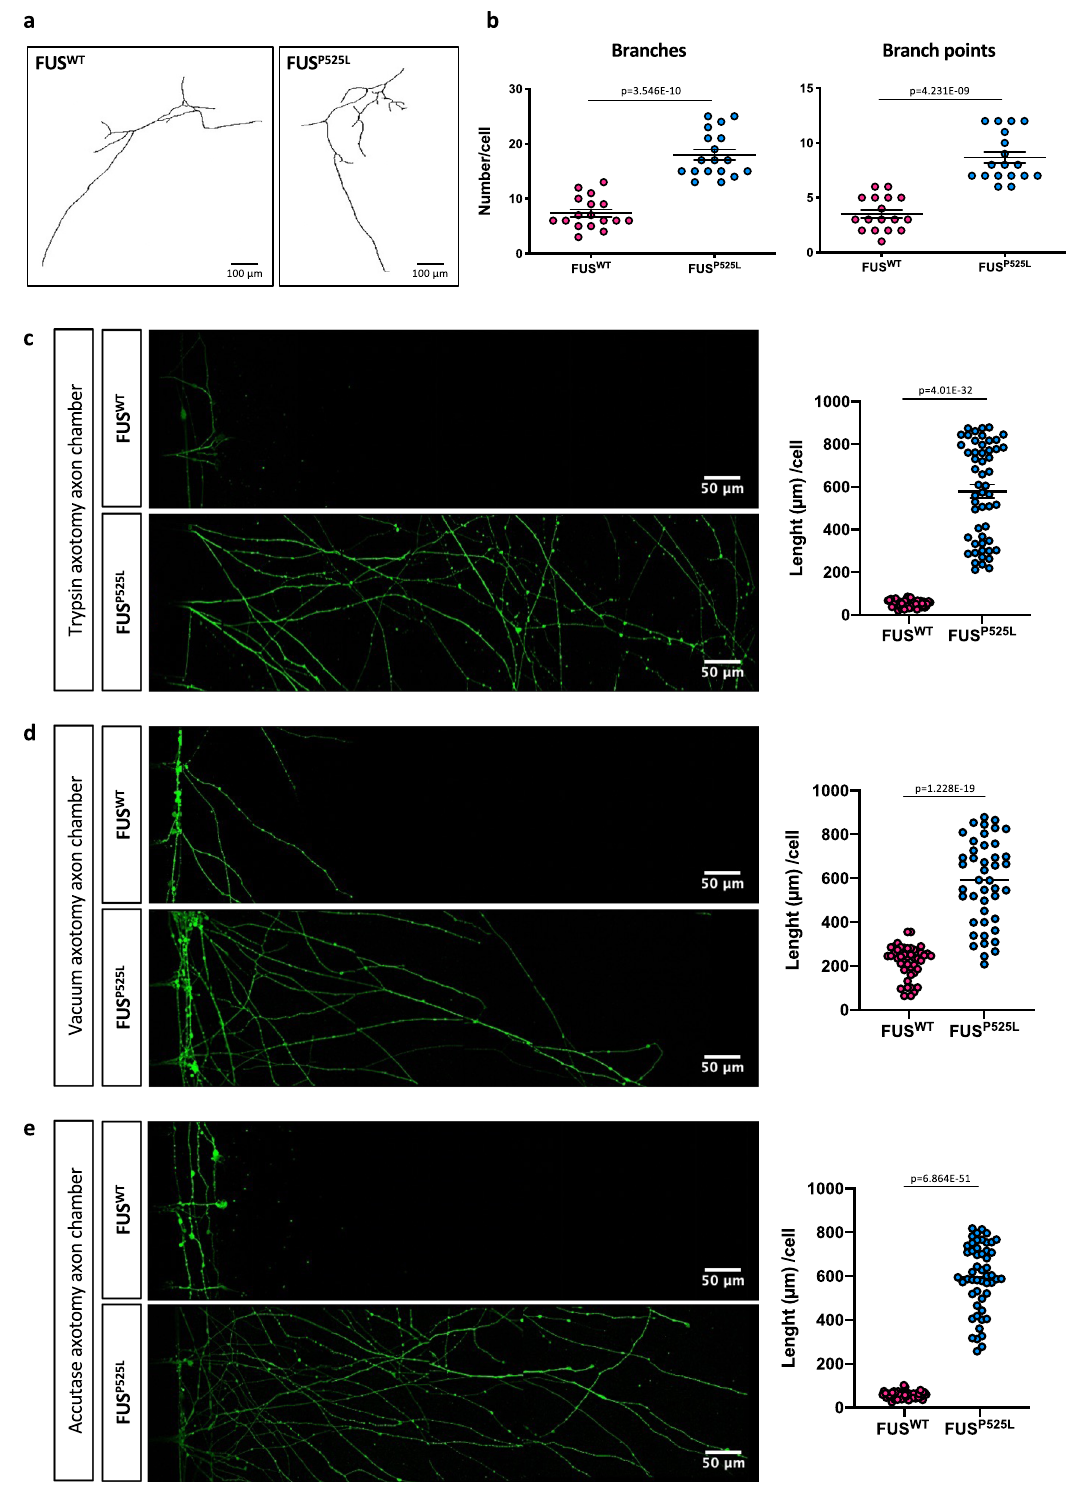
Fig. 4 Axonal phenotypes in hiPSC-derived spinal MNs. a Representative images, generated with the Skeleton plugin of ImageJ, showing axons of FUS WT and FUS P525L hiPSC-derived MNs in the axon chamber of compartmentalized chips. Scale bar: 100 μ m. b Quantitative analysis of the number of axon branches and branch points in cells shown in a . The graphs show the average from three independent differentiation experiments, error bars indicate the standard error of the mean (Student ’ s t -test; unpaired; two tails). c – e Immunostaining of TUBB3 (green) in FUS WT and FUS P525L hiPSC-derived spinal MNs cultured in compartmentalized chips and allowed to recover for 30 h after the indicated treatments to induce axotomy in the axon chamber. Scale bar: 50 μ m. Graphs show quantitative analysis of axon length from three independent differentiation experiments; error bars indicate the standard error of the mean (Student ’ s t -test; unpaired; two